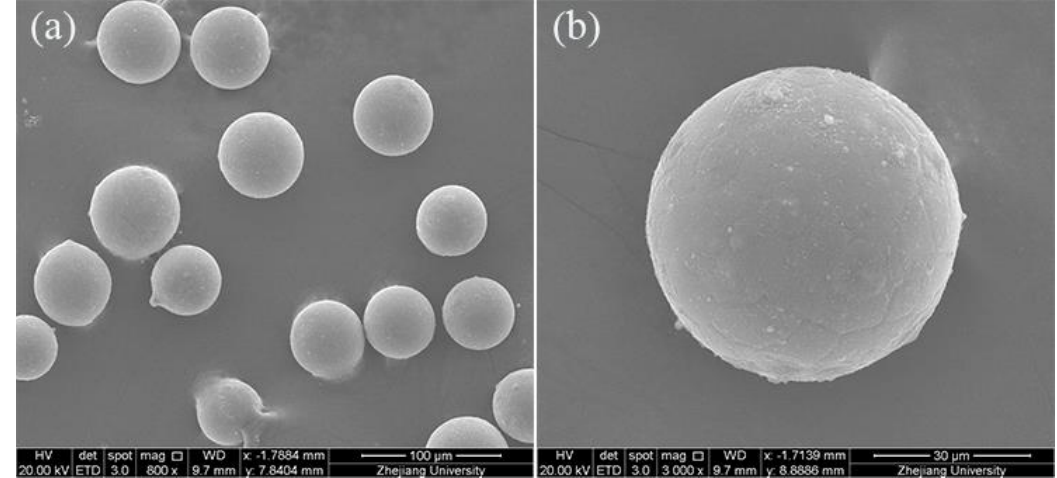
Figure 1. SEM photography of Mg microparticles, ( a ) 800×, ( b ) 3000×. The XRD pattern of Mg microparticles was obtained by an Empyrean X-ray diffrac- tometer (Malvern Panalytical Ltd., Malvern, UK) under Cu Ka radiation of 16 kW, as shown in Figure 2. In total, 8 characteristic diffraction peaks are at 2 θ (marked as filled circles in Figure 2) about 32.20 ◦ , 34.40 ◦ , 36.63 ◦ , 47.83 ◦ , 57.38 ◦ , 63.06 ◦ , 68.64 ◦ , and 70.00 ◦ , which are in accordance with the diffraction peaks of Mg particles.